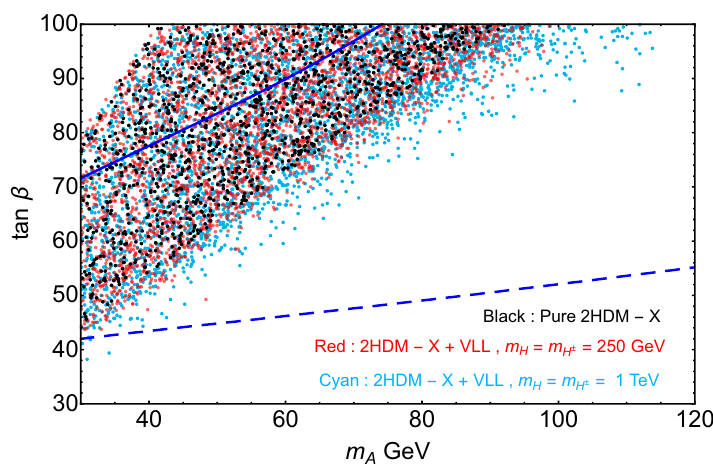
Figure 4 . The parameter space in the m A − tan β plane which can explain muon anomalous magnetic moment at 2 σ . The blue solid and dashed lines depict restriction coming from the measurement of Z → ‘‘